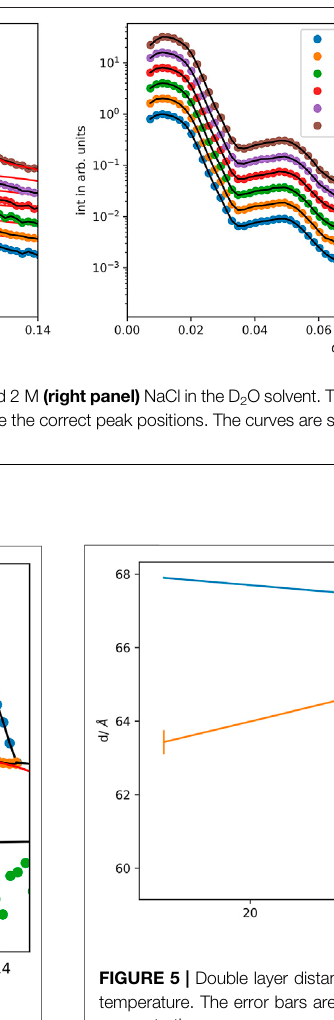
FIGURE 4 | Re fl ectometry data for different NaCl concentrations at physiological temperatures. The curves are shifted along the intensity axis for clarity of the presentation.